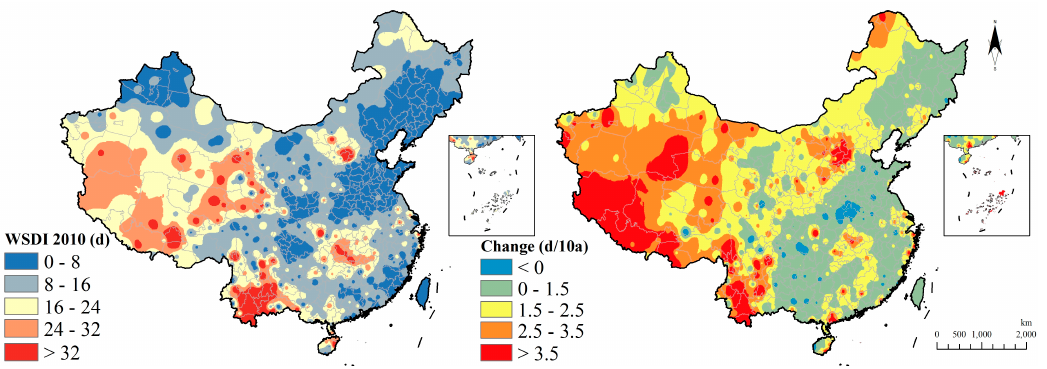
Figure 9. Warm spell duration indicator distribution and change .